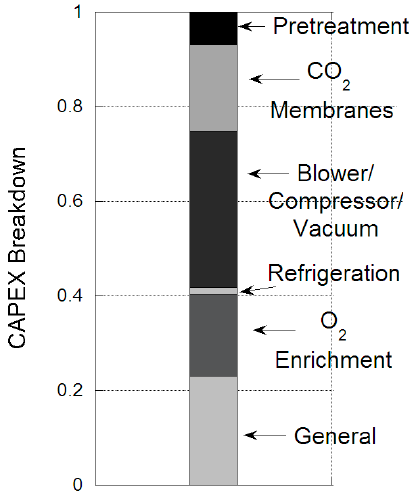
Figure 5. CAPEX breakdown of NGCC post-combustion membrane capture plant.